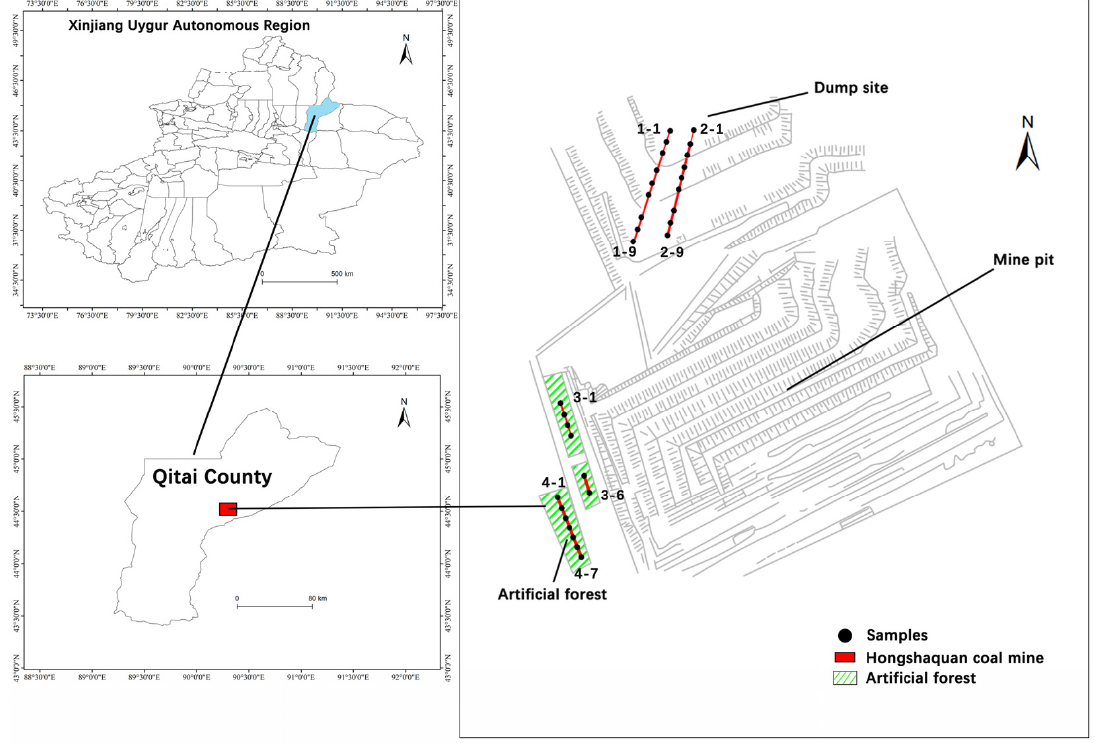
Figure 1. Sampling point layout map. Table 1. Number and location of sampling